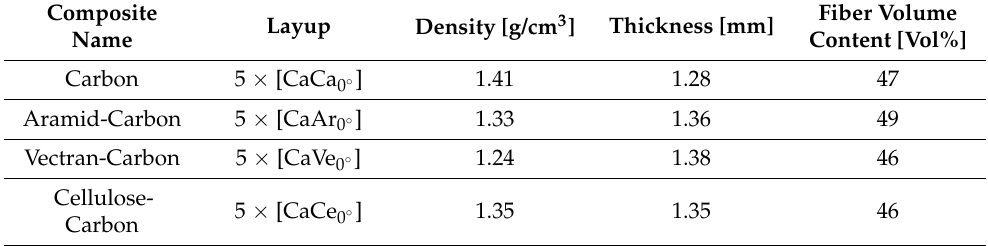
Table 3. Properties of specimens for tensile and damping testing.